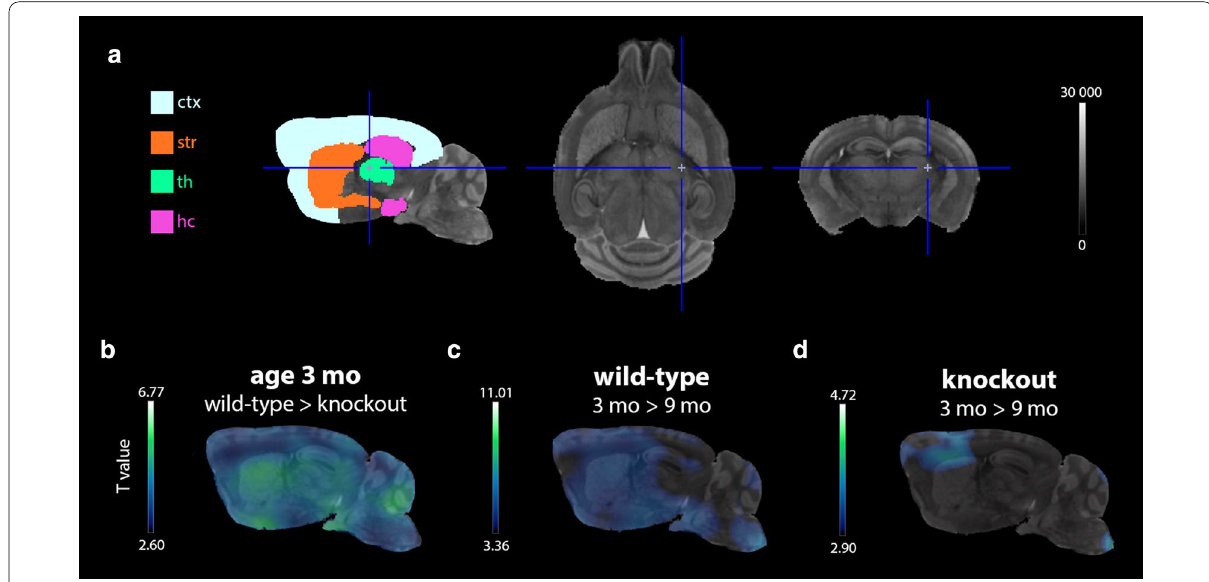
Fig. 3 The results of the voxel-based statistical parametric mapping analysis of the [ 11 C]UCB-J V T(IDIF) maps. a A representation of all analysed brain regions on a corresponding MR template. b Hypo T-map showing all voxel clusters (threshold: 100 voxels) with a significantly ( p < 0.01) lower V T(IDIF) in ko compared to wt mice at the age of 3 mo. c Hypo T-maps indicating all voxel clusters (threshold: 100 voxels) that significantly ( p < 0.01) declined over time in wt mice. d Similar hypo T-maps as in panel c for the ko mice (ctx cortex; hc hippocampus; ko knockout; mo months; = = = = MR magnetic resonance; str striatum; th thalamus; wt = = = =